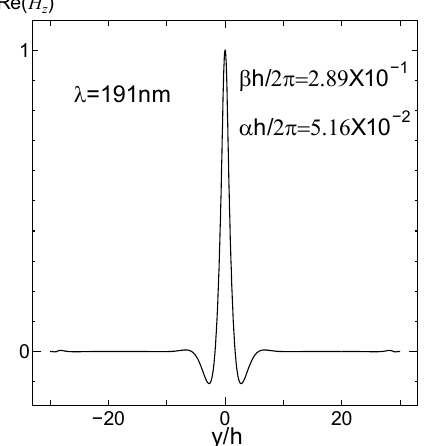
Figure 10. Distribution of the Hz field as a function of the y coordinate representing the wavelength of 191 nm.